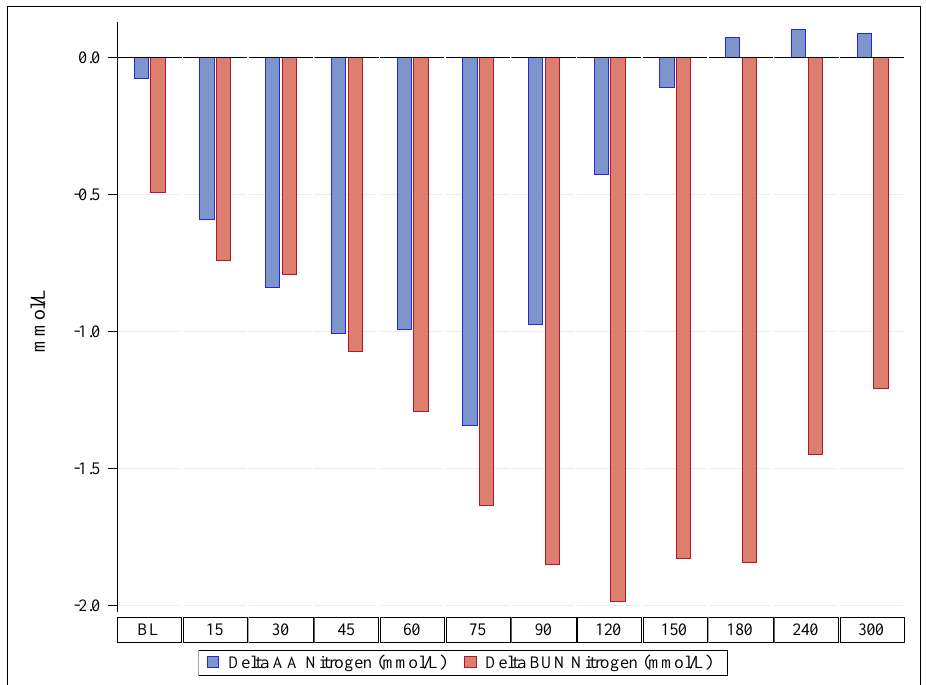
Figure 3. Delta of the nitrogen concentrations contained in plasma amino acids in comparison with Delta nitrogen concentrations as blood urea nitrogen. AAs, amino acids; BUN, blood urea nitrogen.